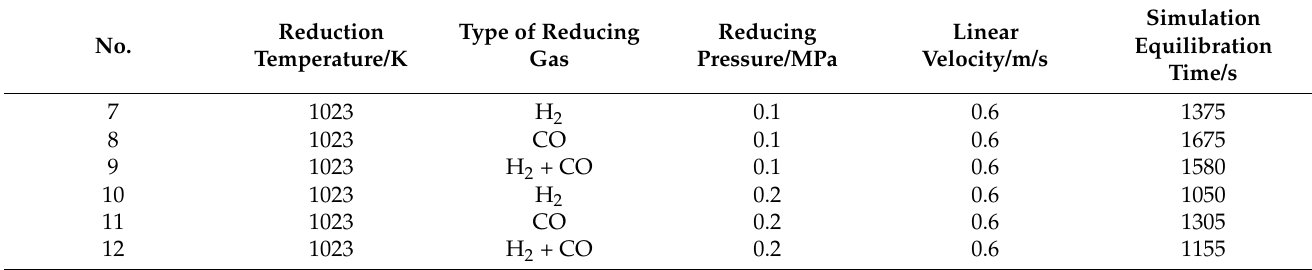
Table 7. Experimental scheme and